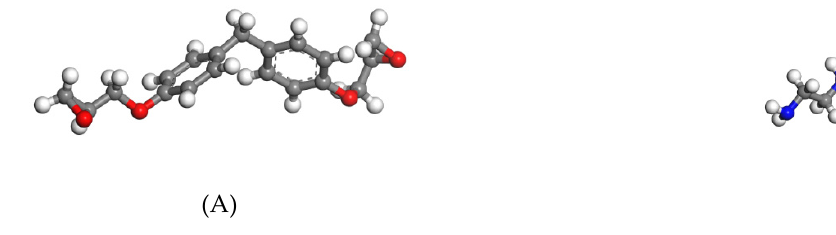
Figure 1. Epoxy resin monomer and curing agent: ( A ) DGEBF; and ( B )